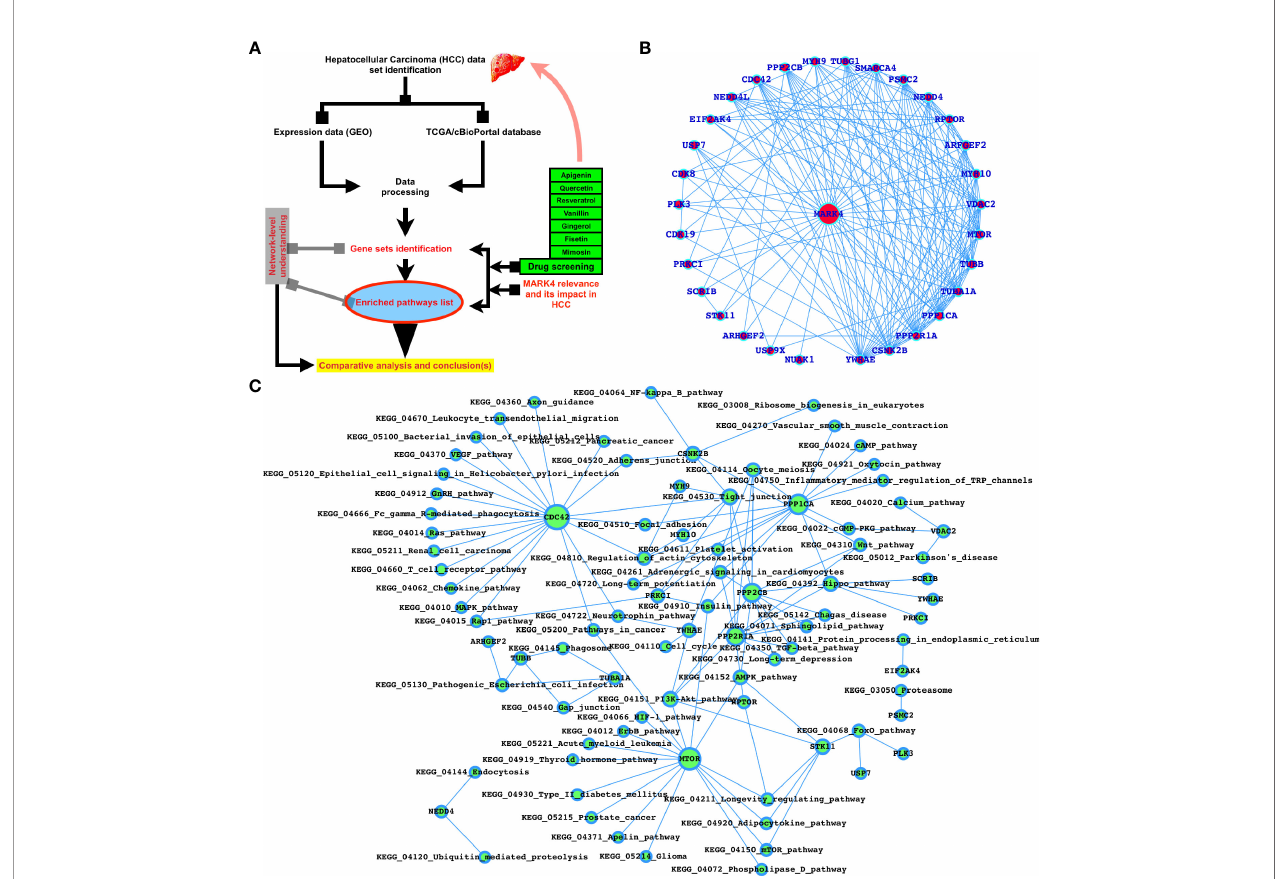
FIGURE 1 | MARK4-interactors pro fi ling and potential drugs target properties. (A) Work fl ow of this study. (B) Top-ranked MARK4 interactors. (C) MARK4- associated